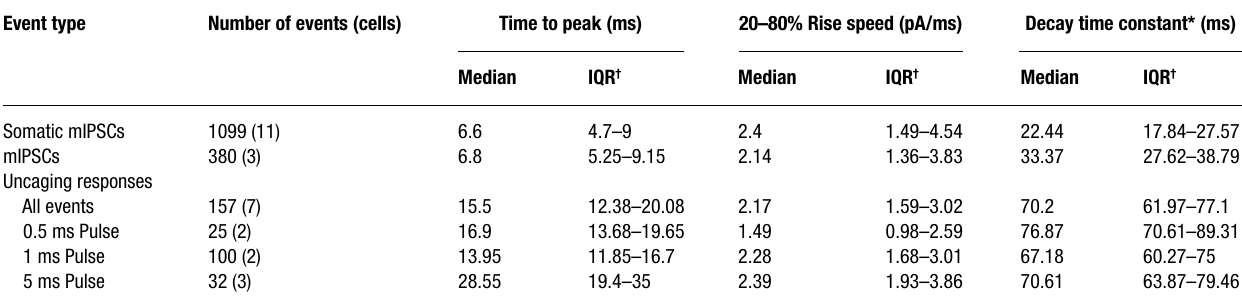
Table 1 | Comparison of kinetics of physiological and uncaging responses.